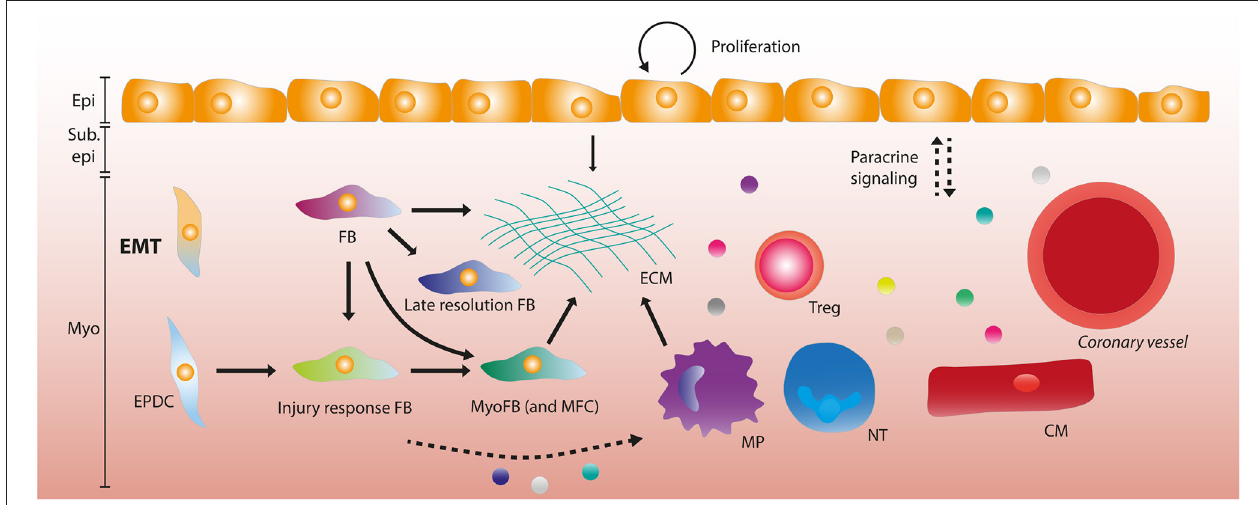
FIGURE 2 | The adult epicardium and stromal heterogeneity after myocardial infarction. After myocardial infarction (MI), the epicardial layer starts proliferating in order to regenerate the lost cells. A subset of epicardial cells undergo epithelial-to-mesenchymal transition (EMT) forming epicardium-derived cells (EPDCs). EPDCs and resident fibroblasts (FBs) can form various stromal cell subtypes, being late resolution FBs and injury response FBs that differentiate into myofibroblasts (MyoFBs) and matrifibocytes (MFCs). Several of these FB subgroups can contribute to extracellular matrix (ECM) deposition. Macrophages (MPs) and the epicardial layer also contribute to ECM formation. Paracrine signaling (depicted by dashed arrows) occurs between the epicardial layer and leukocytes (MPs, neutrophils (NTs) and regulatory T cells (Tregs), vessels and cardiomyocytes. Some stromal subsets have been implied to interact with MPs and NTs through paracrine signaling. Epi, Epicardium; Sub epi, Subepicardium; Myo,